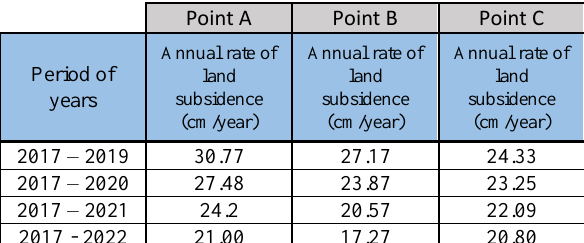
Table 4. Predicted rate of land subsidence at selected points